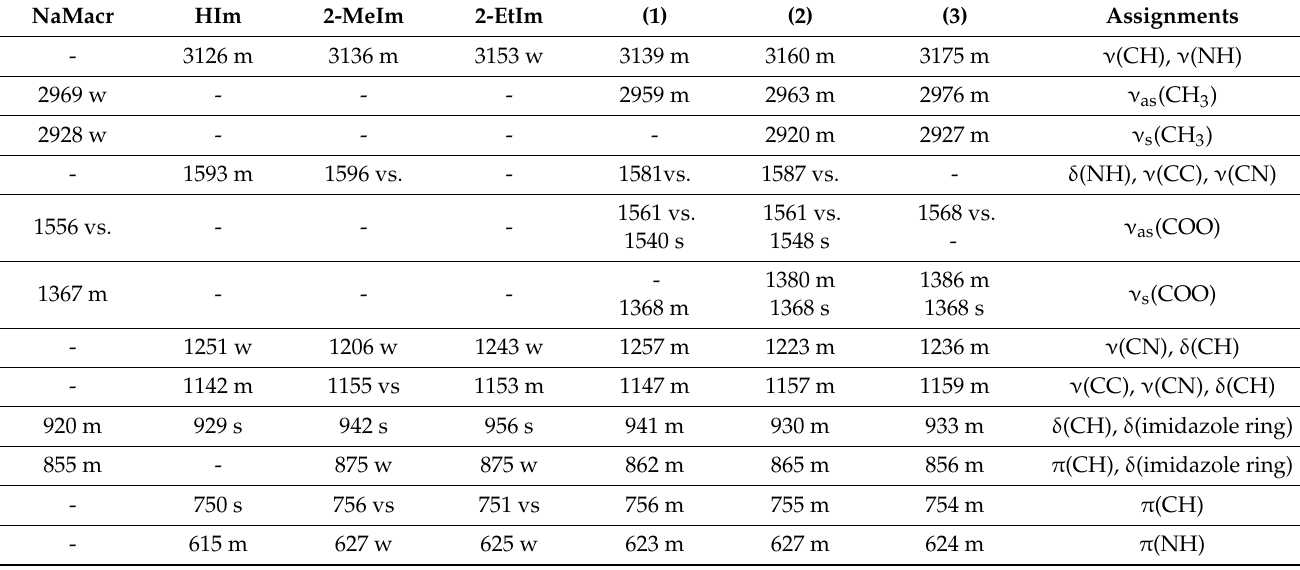
Table 3. Infrared absorption bands (cm − 1 ) for ligands and complexes.